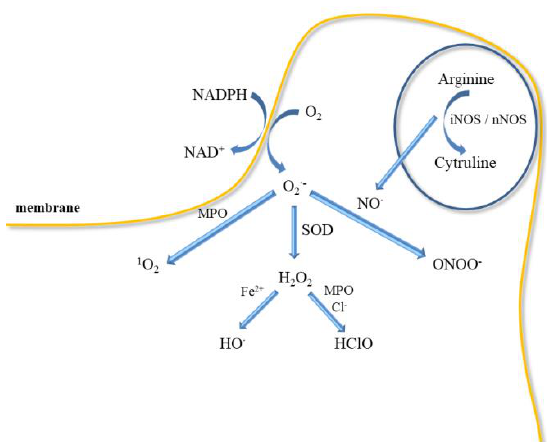
Figure 5. ROS can destroy phagocytized pathogens. Respiratory burst of neutrophil, which leads to